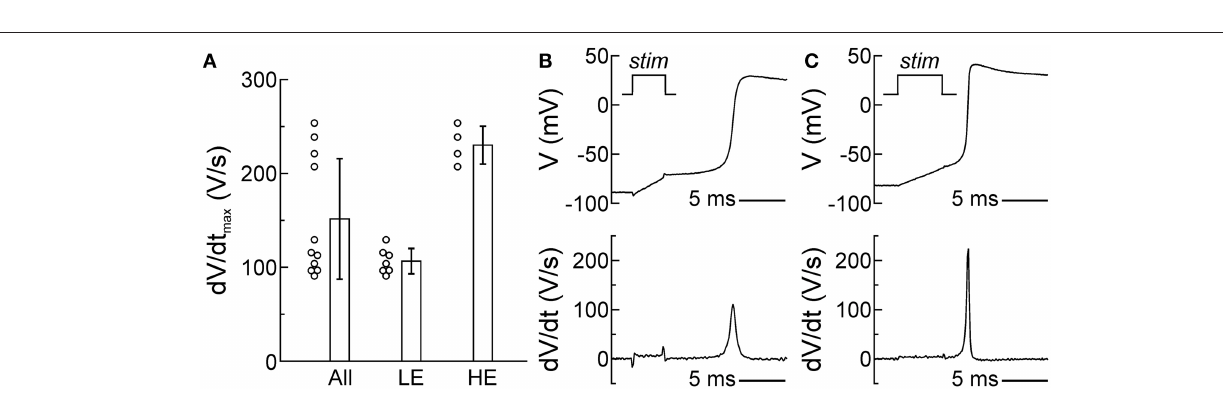
Frontiers in Cell and Developmental Biology |